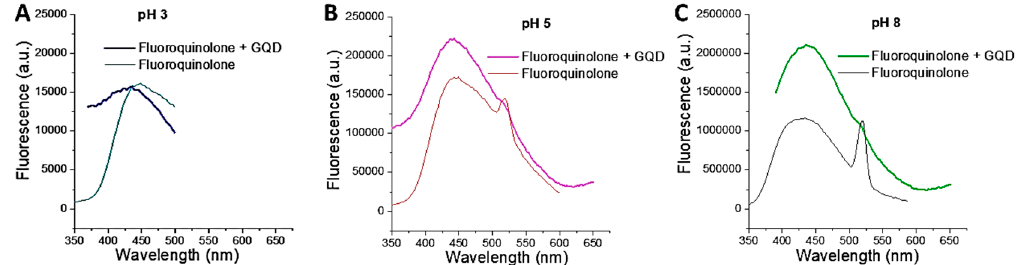
Figure 4. Emission spectra of norfloxacin (at 16.65 ng · L − 1 ) in the presence and absence of e-GQDs (at